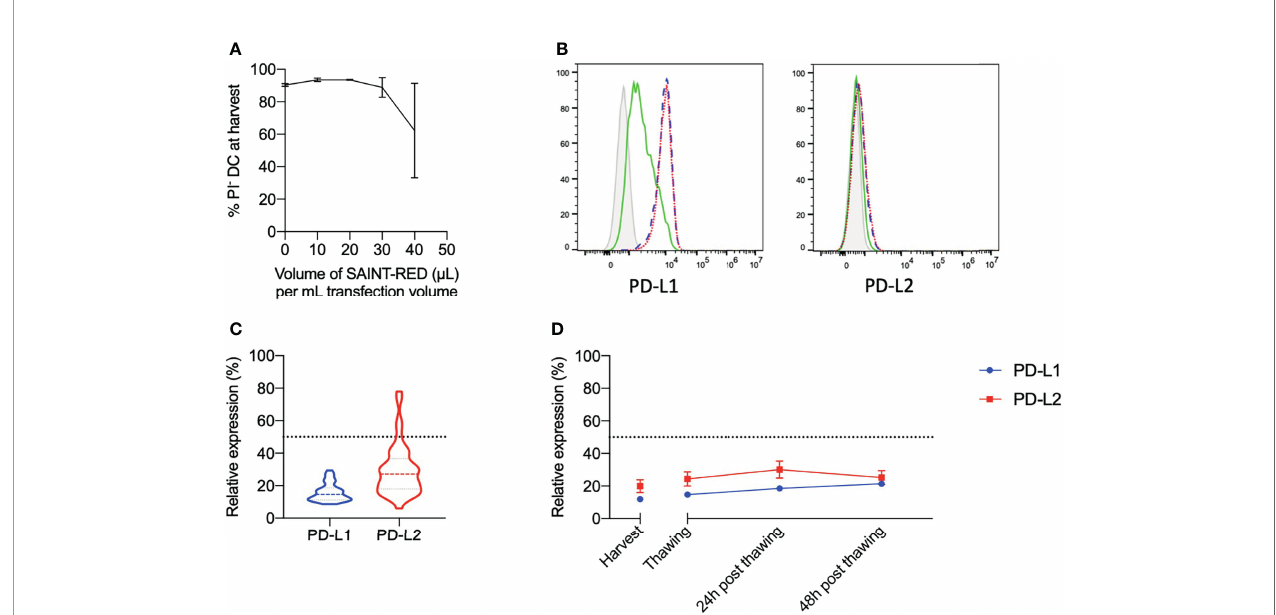
FIGURE 1 | Optimization of siRNA transfection protocol in monocytes and assessment of transfection ef fi ciency assessed on mature IL-15 DCs. (A) The effect of increasing concentrations of SAINT-RED lipofectant (expressed in µL/mL transfection volume for 4.5-6.0 x 10 6 monocytes/mL) on mature IL-15 DC viability at harvest was assessed fl ow cytometrically with PI (n = 3). (B) Representative histogram overlays of the surface expression of PD-1 ligands PD-L1 and PD-L2 in mature IL-15 DCs at harvest from untreated (blue dashed line), luciferase siRNA-treated (red dotted line), and PD-L siRNA-treated (green line) monocytes. Grey fi lled line represents the corresponding isotypes. (C) Relative expression of PD-L1 and PD-L2 in mature PD-L siRNA IL-15 DCs compared to luci siRNA IL-15 DCs of PD- L1 and PD-L2 at harvest (n = 48). The horizontal dotted line indicates a cut-off value of 50% relative expression as indicator of successful silencing. (D) Kinetics of surface PD-L1 and PD-L2 relative expression on fresh mature IL-15 DCs at harvest and 1, 24 or 48 hours after thawing (n = 8). PD-L1, programmed death-1 ligand 1; PD-L2, programmed death-1 ligand